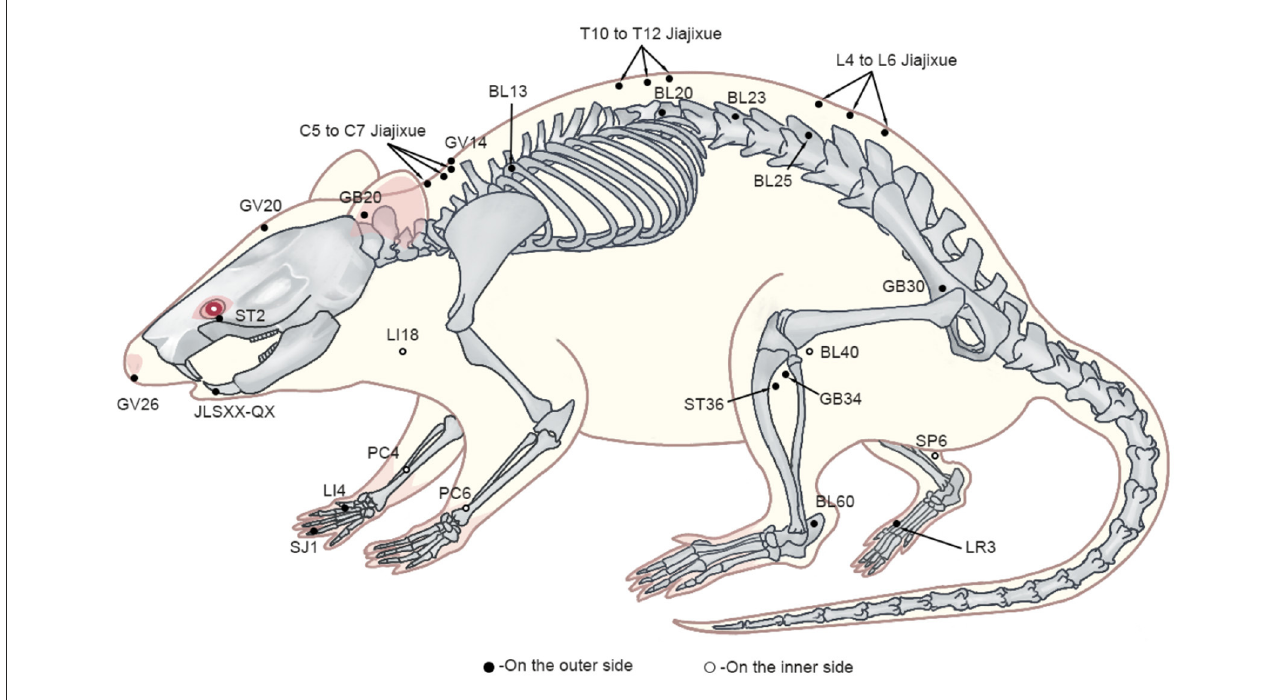
FIGURE2 The schematic representation of